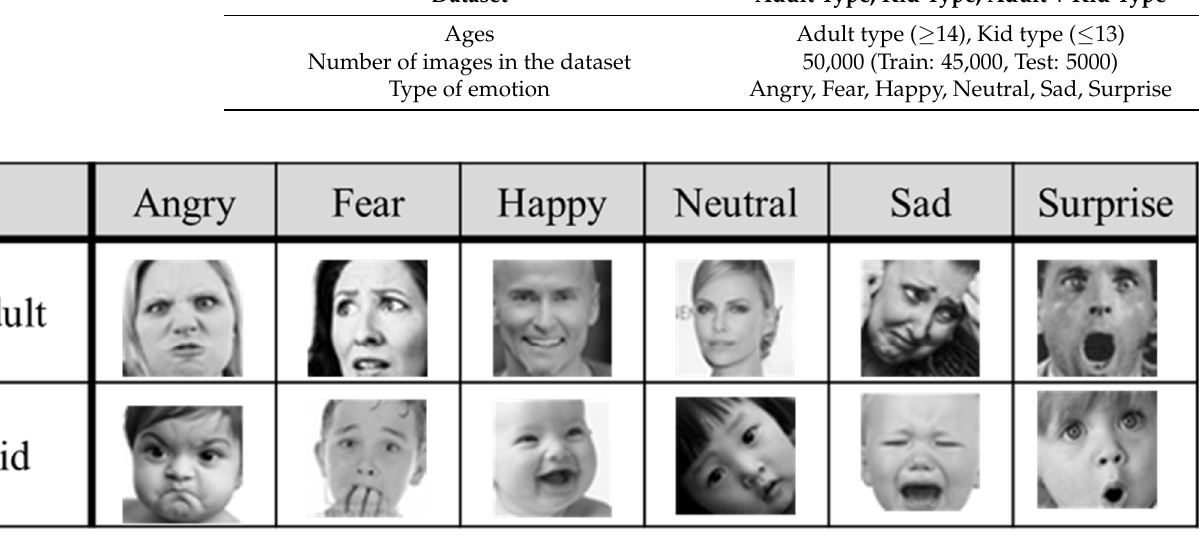
Figure 1. Example of FER2013.